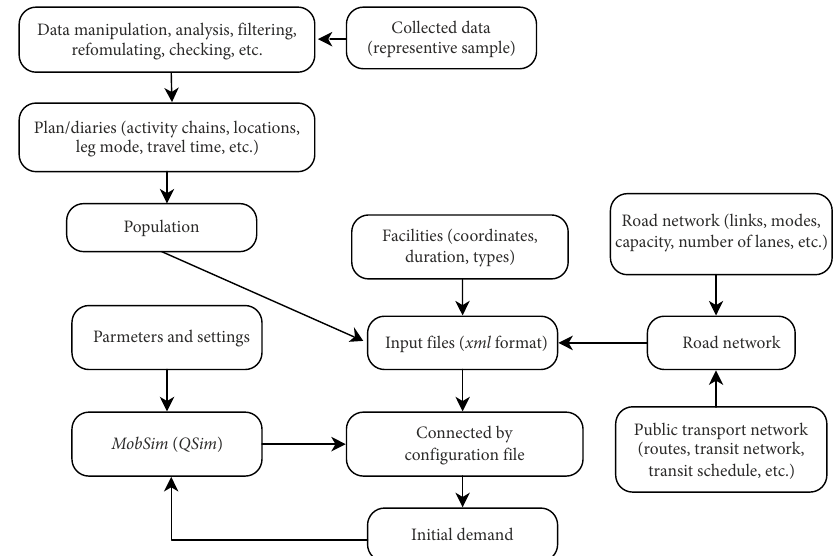
Figure 2. Initial demand preparation mobility